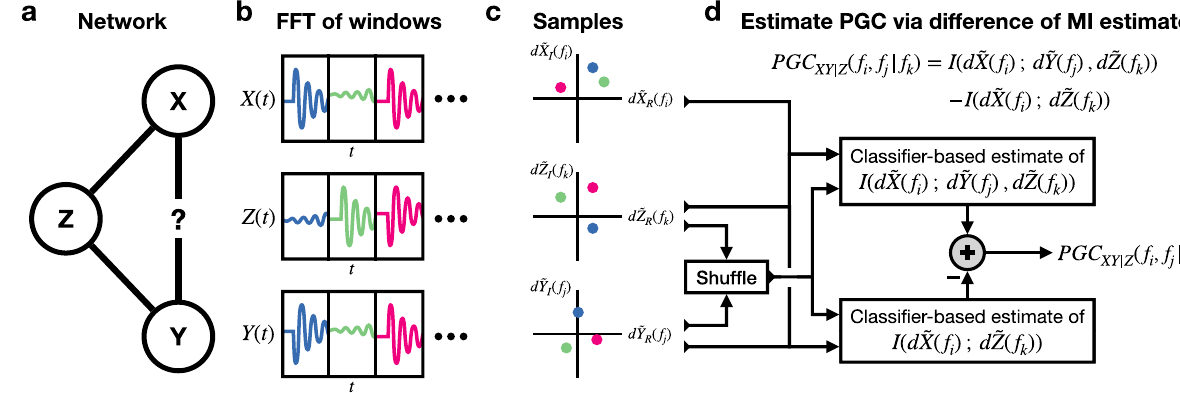
Figure 2. Overview of PGC estimation process. ( a ) Consider estimating the PGC between the processes X at f i and Y at f j conditioned on a third process Z at f k . ( b ) Non-overlapping windows of the corresponding processes X ( t ), Y ( t ), and Z ( t ) are taken and then the FFT of each window is computed. ( c ) The FFT of each window of each process provides a complex sample of the spectral increment of interest. ( d ) Spectral increment samples are permuted to provide shuffled samples, and the degree to which a trained binary classifier can differentiate between the original and shuffled samples yields each MI estimate. Taking the difference of the two MI terms provides an estimate of